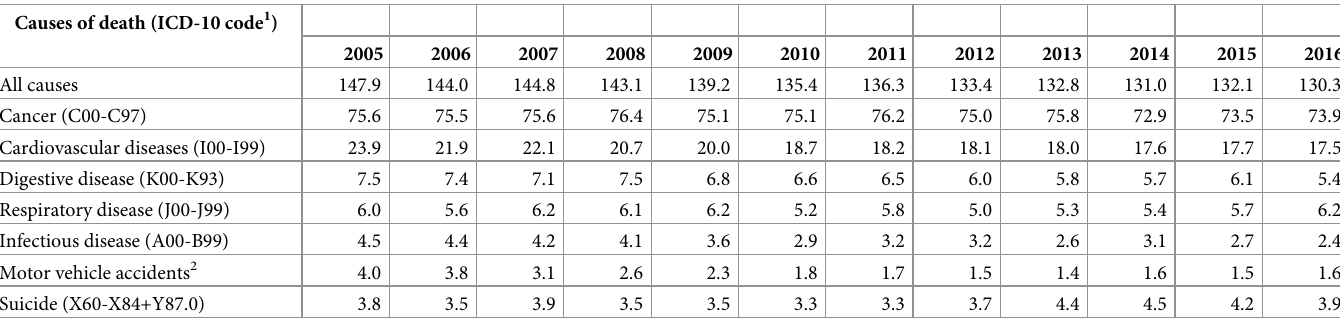
Table 2. Age-adjusted annual mortality rate per 100,000 people by cause of death in the Spanish women aged 15 to 64 years, 2005–2016. Causes of death (ICD-10 code 1